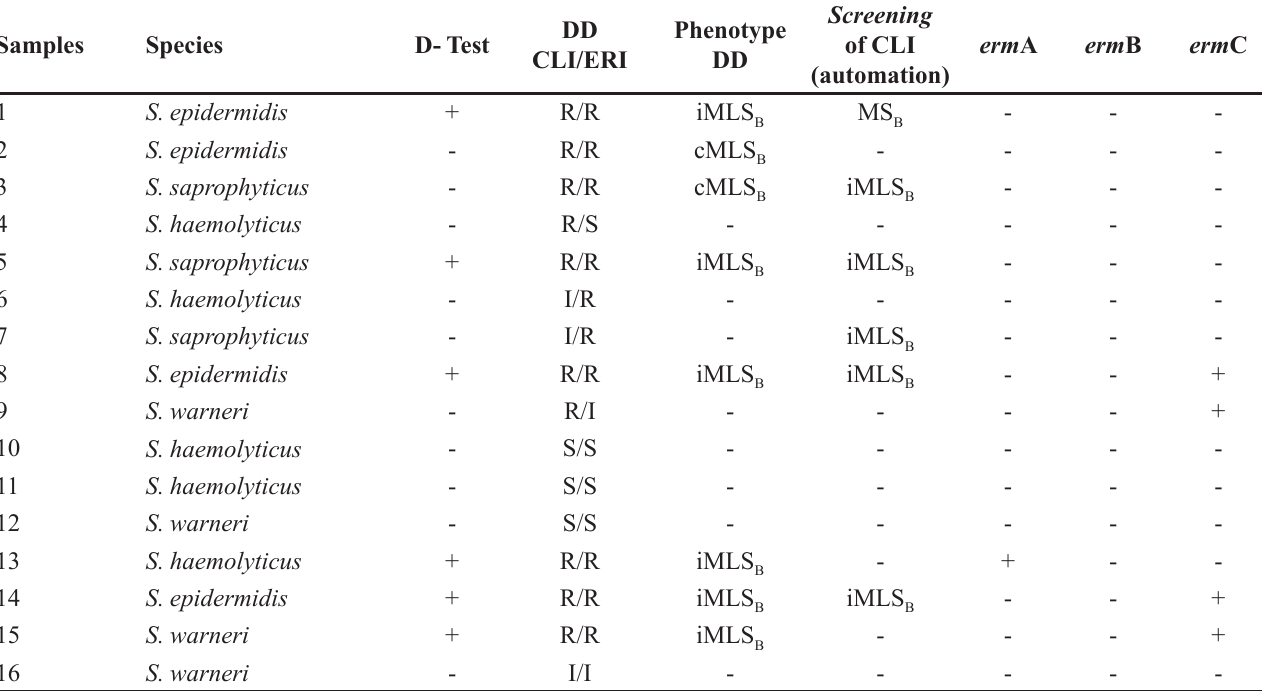
S = Susceptible; I = Intermediate; R = Resistant; “-“= absence; “+”= presence; Cli = Clindamycin; Eri = Erythromycin; D-Test Negative = cMLS (resistant to CLI and ERI); D-Test Negative = MS B iMLS (resistant to CLI and B